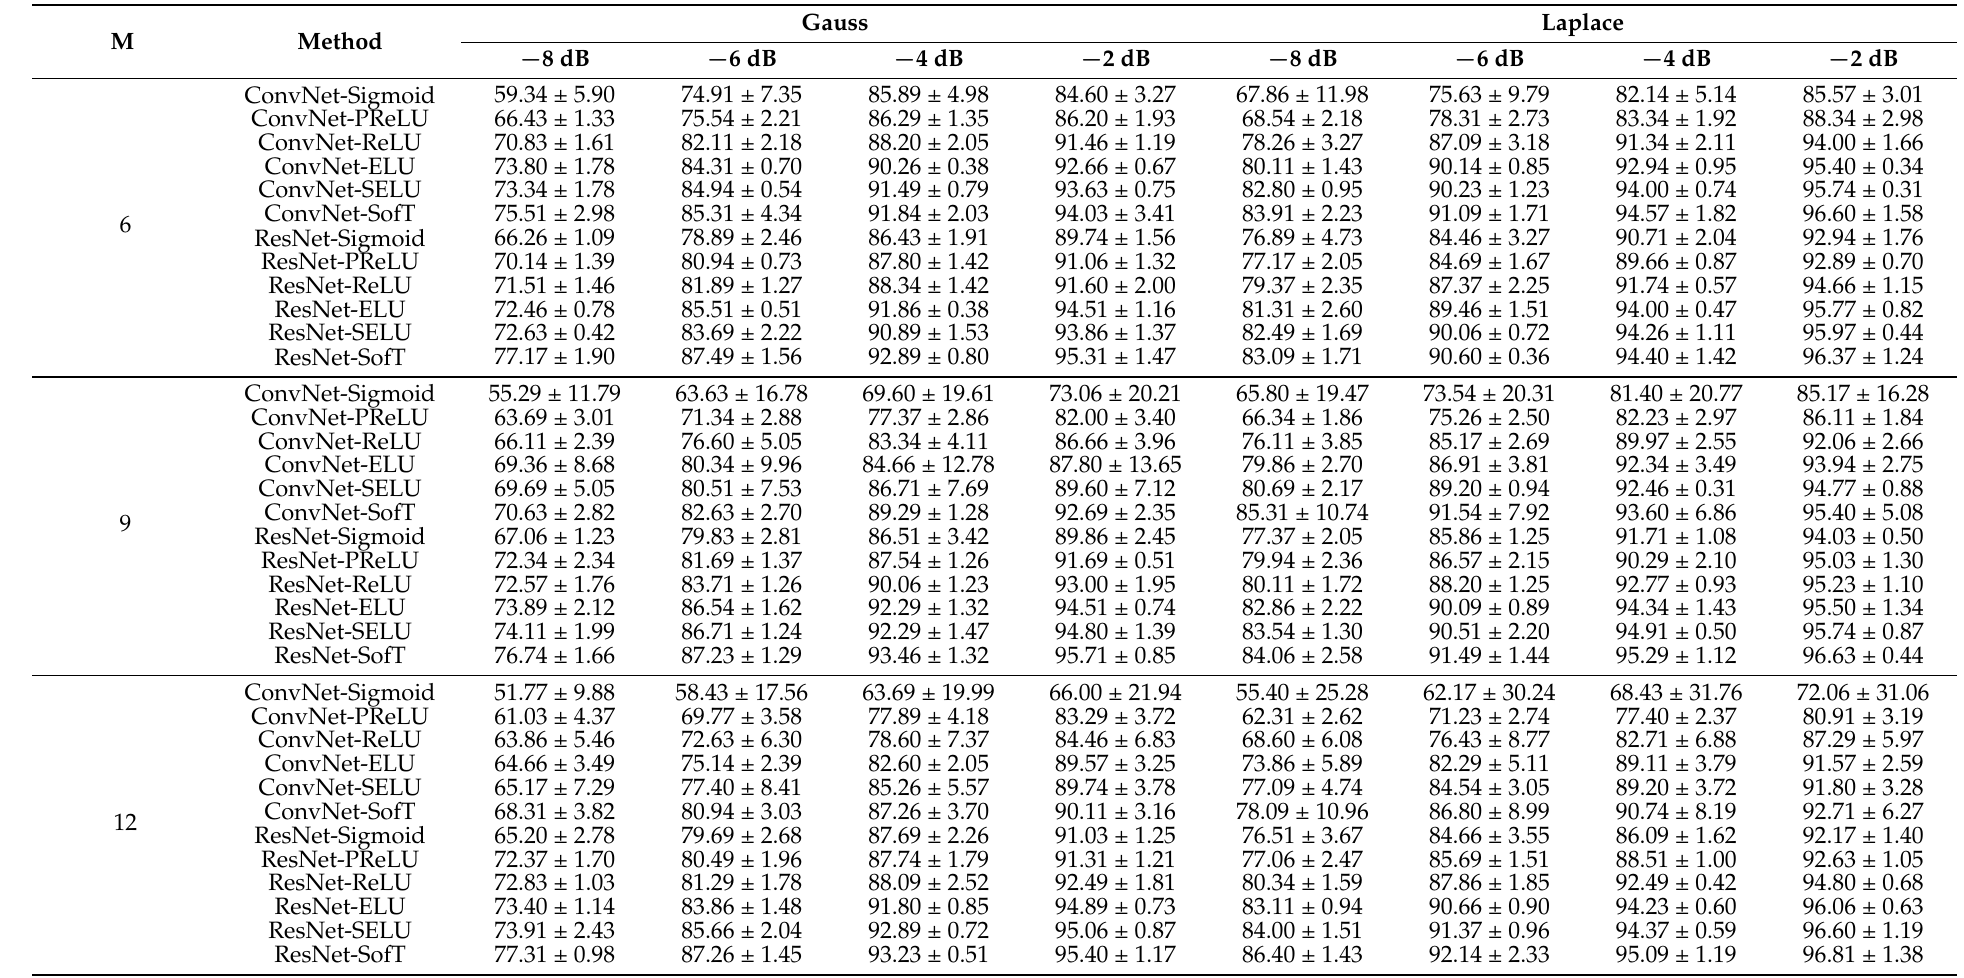
Table 3. The average accuracy of the testing set, where M is the number of ResBlocks or ConvBlocks (i.e., ConvBlocks without identity shortcuts)